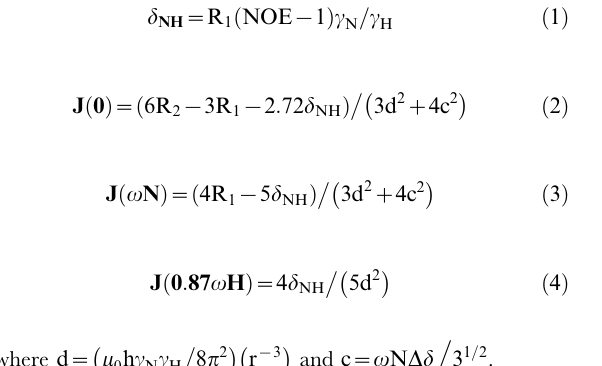
Figure 2. CD characterization. Far-UV CD spectra of the wild-type SH3 and its insertion mutants which were collected at protein concentrations of , 20 m M at 25 u C on a Jasco J-810 spectropolarimeter. The wild-type SH3 was dissolved in 5 mM phosphate buffer (pH 6.2) while the four insertion mutants were solubilized in salt-free water (pH 4.0).